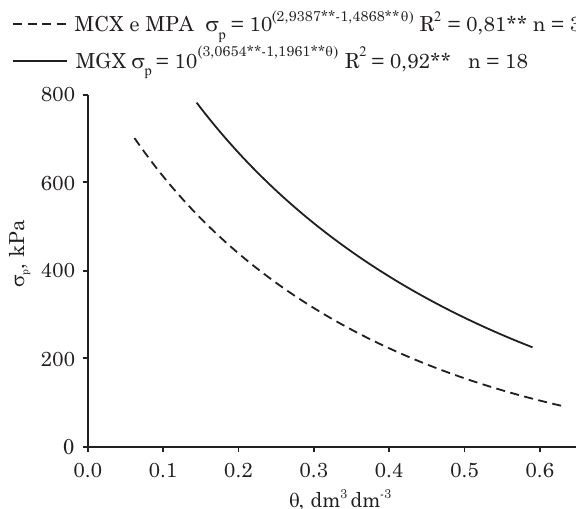
Figura 3. Novo modelo de capacidade de suporte de carga ajustado para o Argissolo (MPA) e Cambissolo (MCX) e modelo de capacidade de suporte de carga para um Gleissolo (MGX).